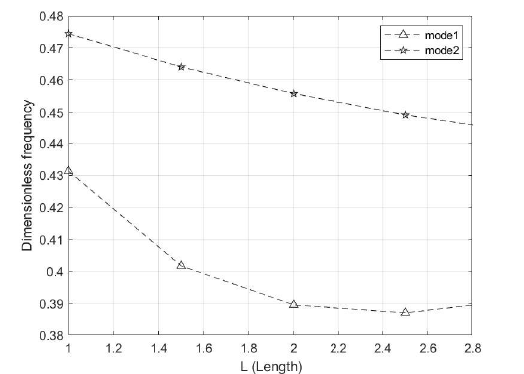
Figure 4. The evolution of the frequency of the first trapped mode with cavity